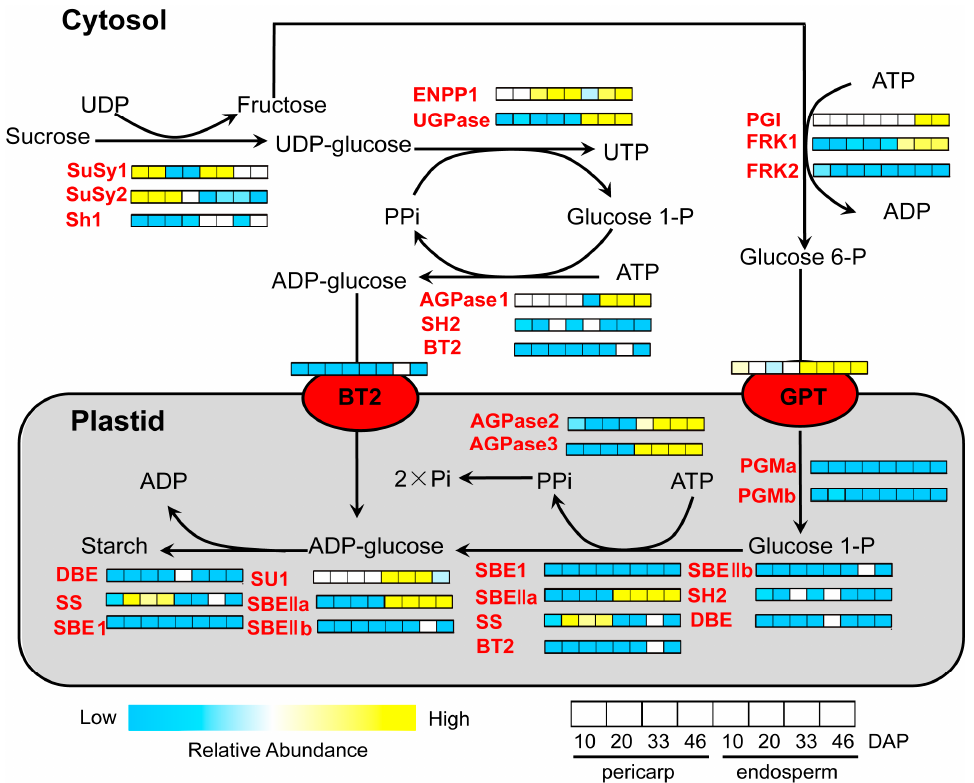
Figure 7. Dynmics of starch biosynthetic pathway during development stages of pericarp and endosperm. The starch biosynthesis pathway was adapted from Nougue and Corbi [52]. Heat maps depict the relative abundance of individual proteins throughout development in pericarp and endosperm. Metabolic pathway showing the major points of regulation for starch biosynthetic. The color scale shows the relative abundance of individual proteins throughout development (blue, ≤ 0.67-fold; yellow, ≥